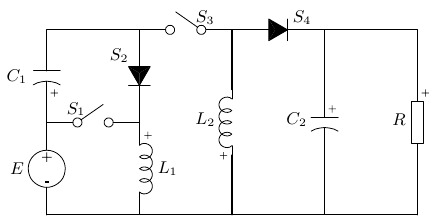
Figure 3. Proposed quadratic buck–boost